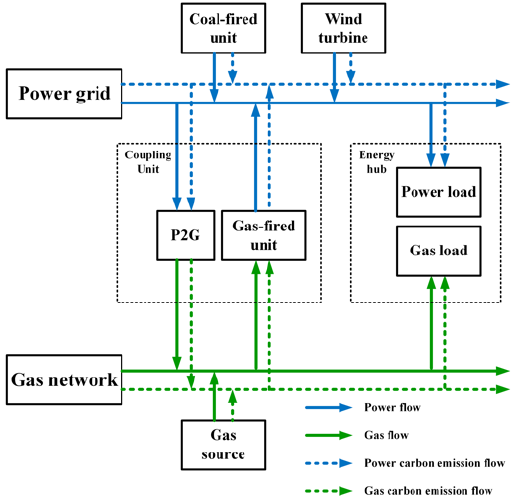
Figure 1. The structure of an electric-gas IES.